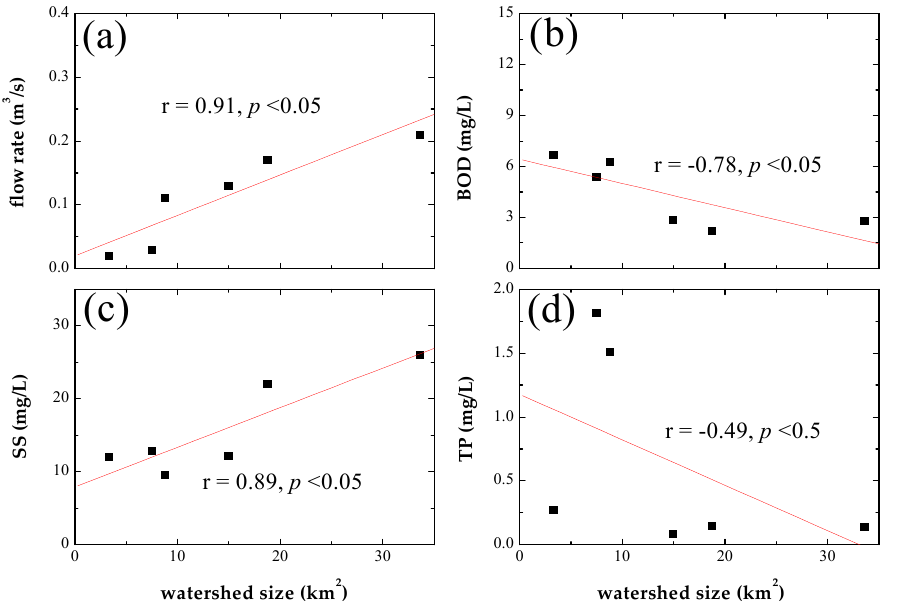
Figure 4. Relationship of the watershed size of the coastal streams, which show changes in cluster according to seasons (as shown in Figure 3, n = 6), with ( a ) flow rate, ( b ) BOD, ( c ) SS, and ( d ) TP.